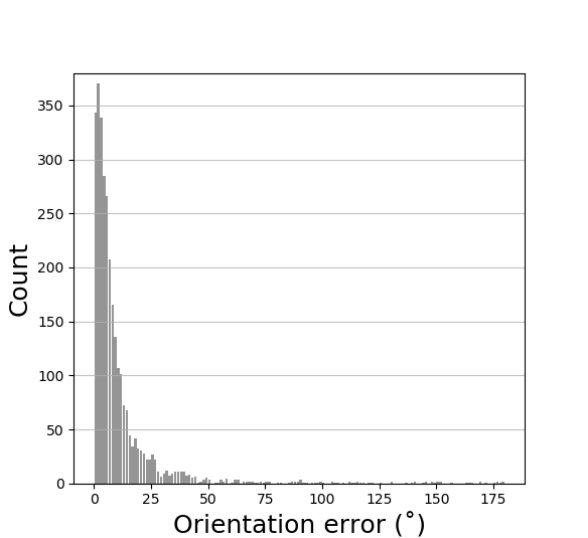
Figure 3: The distribution of raw orientation error throughout the experiment.